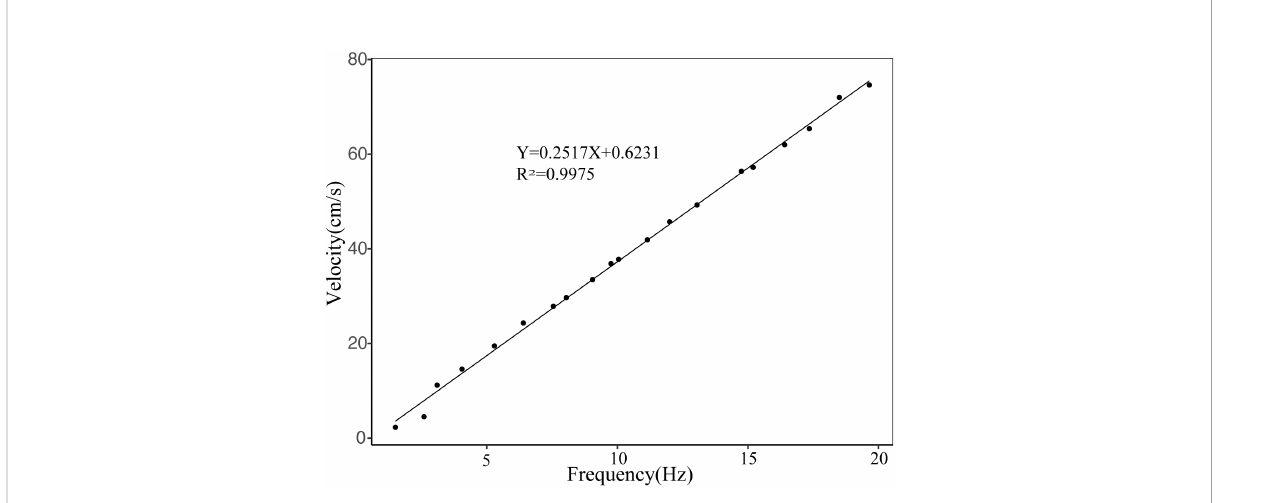
FIGURE 3 The relationship between frequency and velocity. Control the speed of water fl ow by adjusting the frequency of the inverter of the device of swimming performance